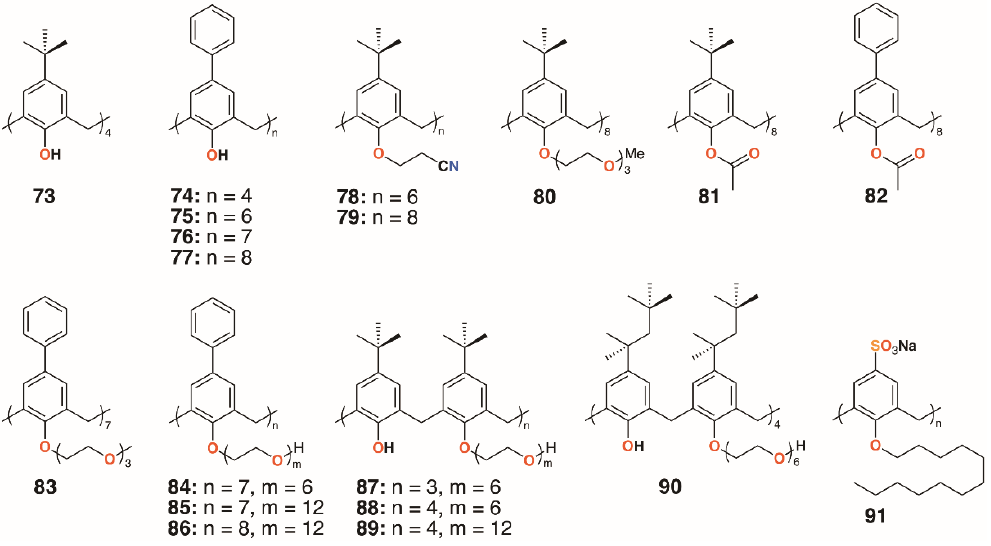
Figure 14. Hailes’ Macrocyclon analogues.